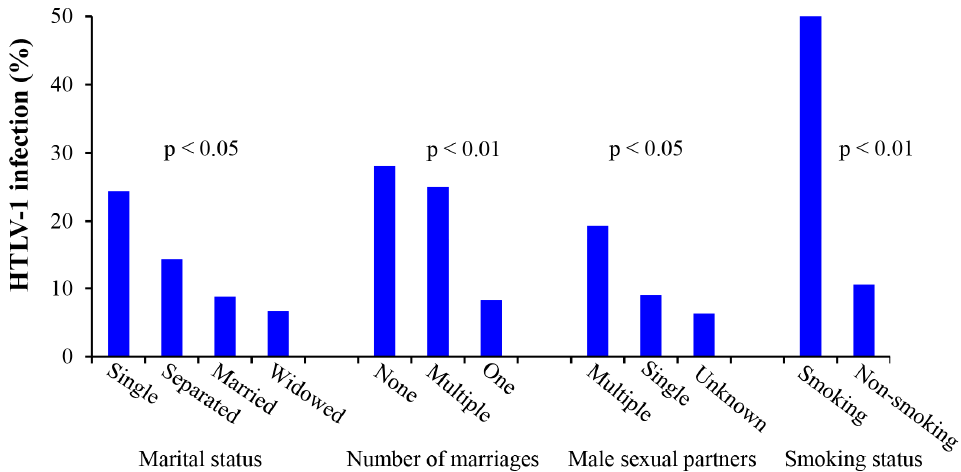
Figure 4. Analysis of the relationship between HTLV ‐ 1 infection and life styles factors. The rate of HTLV ‐ 1 infection in the smoking group was five times higher than that in non ‐ smoking group. Women with increased numbers of marriages and sexual partners were significantly more likely to have HTLV ‐ 1 infections confirming that sexual contact is an important means of HTLV ‐ 1 transmission.